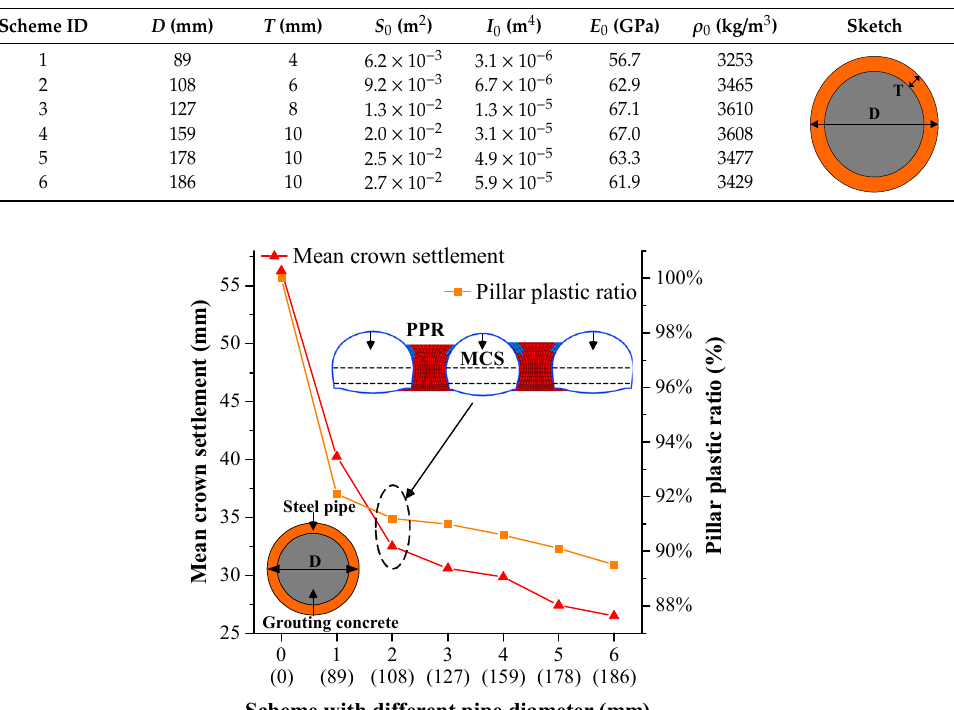
Figure 12. Effect of pipe arrangement angle on MCS and PPR.